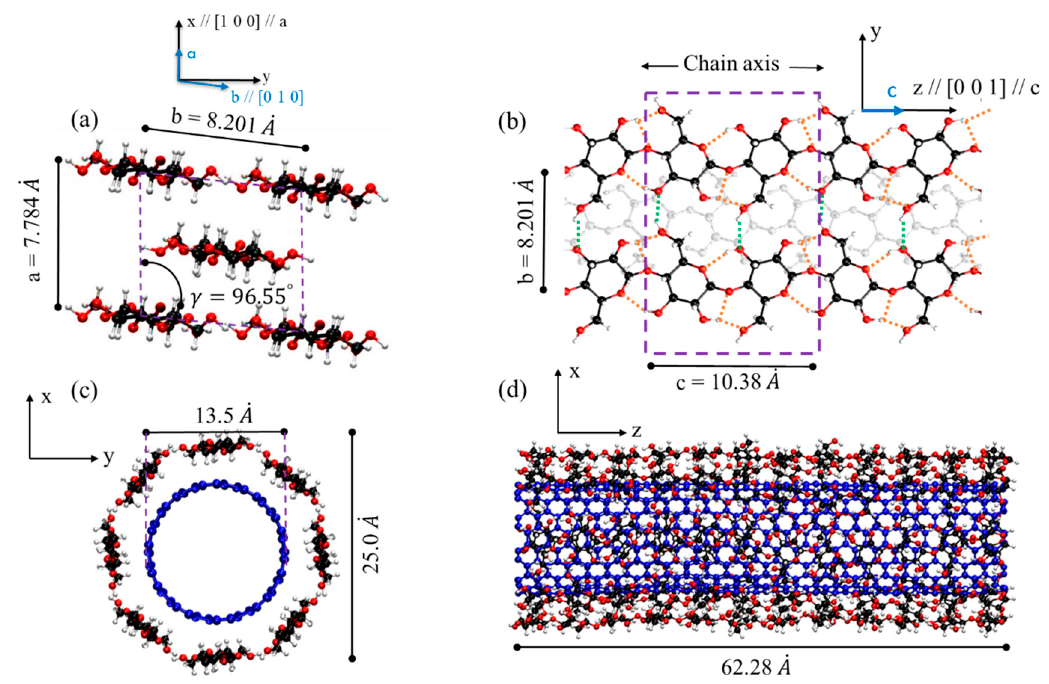
Figure 1. Molecular model of crystalline nanocellulose (CNC), and carbon nanotube (CNT) wrapped by a single layer of cellulose chains. Red spheres represent oxygen atoms, black spheres represent carbon atoms in CNC, white spheres represent hydrogen atoms, and blue spheres are carbon atoms in CNT. ( a ) Atomistic structure of CNC unit cell from cross-section view adapted from [29,49]. (Reproduced with permission from [29]. Elsevier, 2018). ( b ) CNC view along chain direction (c-axis). ( c ) Cross-section view of CNT-wrapped by one layer of aligned cellulose chains (similar to CNC). ( d ) View of CNT-wrapped cellulose along the axial direction of CNT.